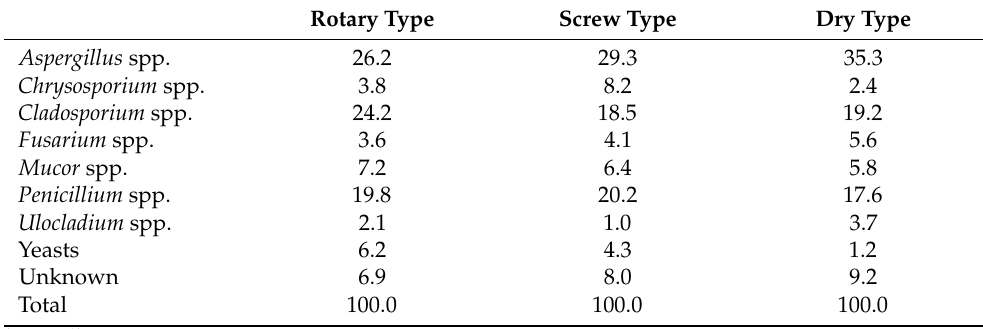
Table 3. Identification of airborne fungi in livestock manure composting plant. Rotary Type Screw Type Dry